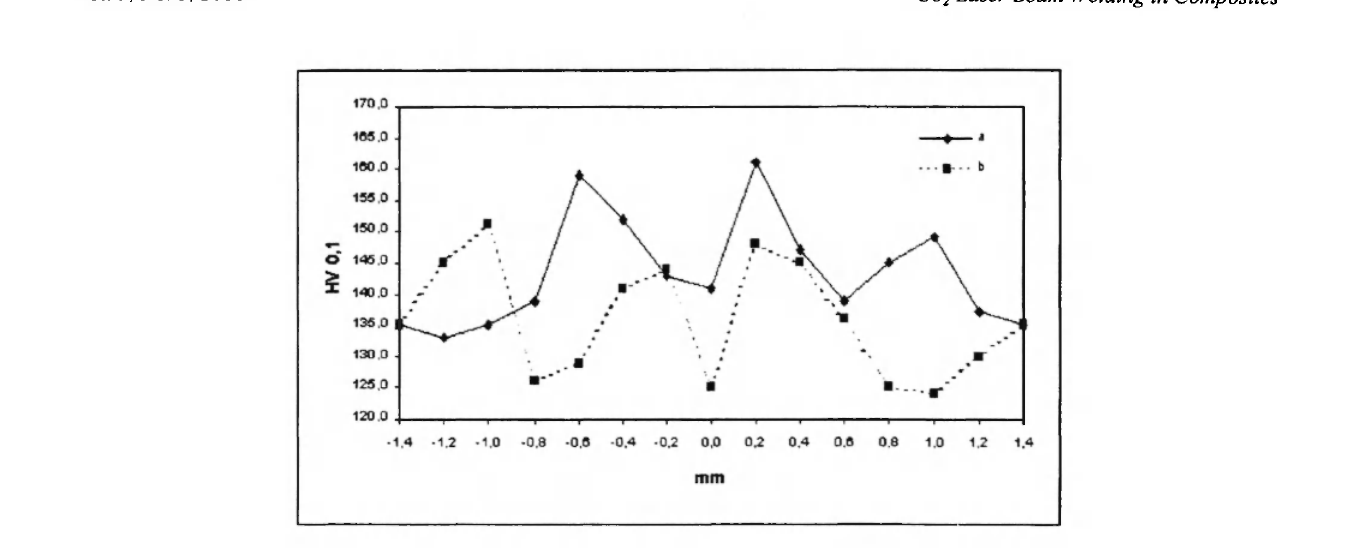
Fig. 8: Microhardness profiles in the welded upper zone of 2618 samples joined without a) and with b) filler material (Power = 4 kW, Feed rate = 4 m/min).